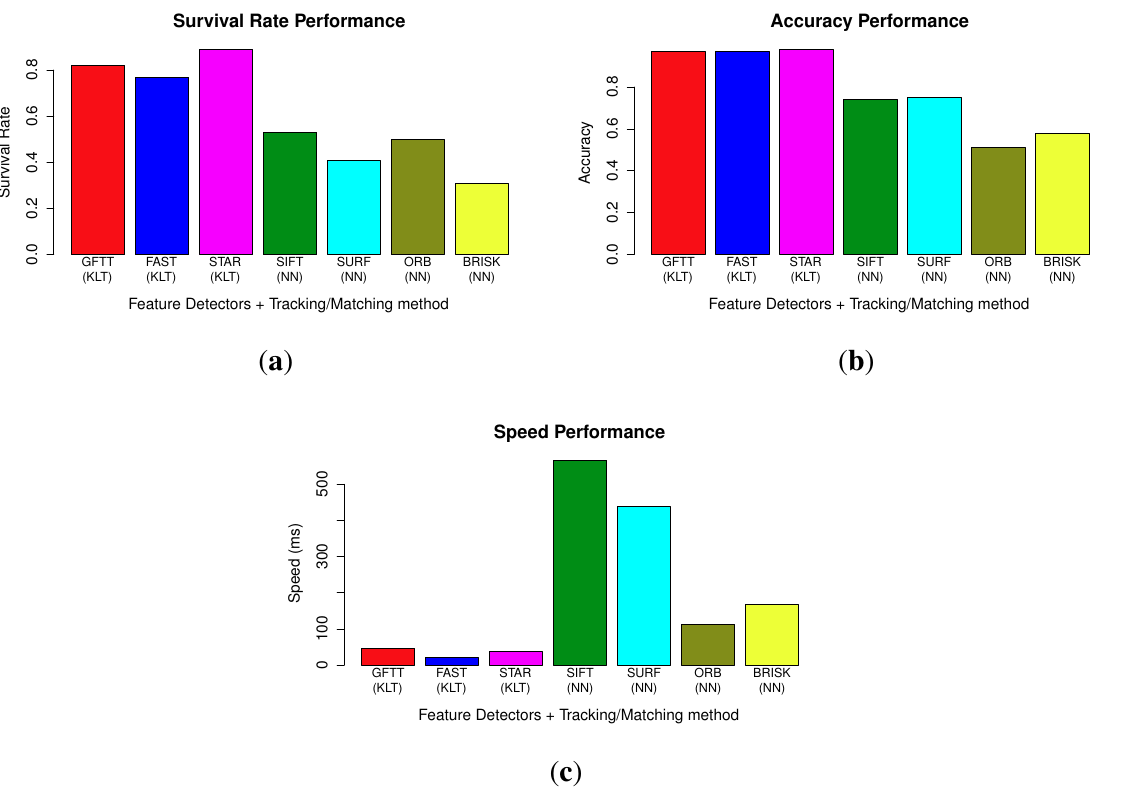
Evaluating the process of circular building point-to-point